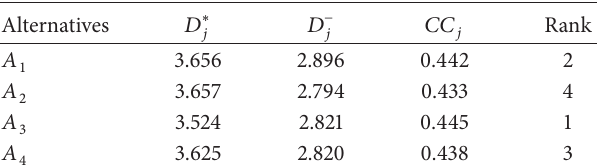
Table 9: FTOPSIS results of ideal solutions and ranking of alterna- tives.